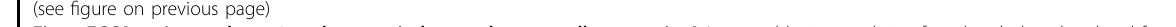
Fig. 5 ECCA activates the p53 pathway to induce melanoma cell apoptosis. A Immunoblotting analysis of total and phosphorylated forms of p53 and p21 in UACC62 cells treated with or without ECCA at the indicated concentrations and times. Red and blue arrows, respectively, indicate the upregulated expression of p-p53 at Ser15 and p21. GAPDH is a housekeeping gene used as a loading control. B Quanti fi cation of the relative levels of p-p53 and p21 in A , as a relative fold change to the respective control cells, indicated by a dashed line as 1, after each phosphorylated protein was normalized to the corresponding total protein band. C Immunoblotting analysis of total and phosphorylated forms of p53 in UACC62, A375, Mel- Juso, M14, and WM115 cells treated with ECCA at 5 μ M at 24 h. Green arrows indicate the upregulated expression of p-p53 at Ser15. GAPDH is a housekeeping gene used as a loading control. D Quanti fi cation of the relative levels of p-p53 in C , as a relative fold change to the respective control cells, indicated by a dashed line as 1, after each phosphorylated protein was normalized to the corresponding total protein band. E UACC62 cells were transfected with three independent p53 siRNAs, and at 48 h after transfection, the cells were treated with 5 µM ECCA. At 24 h, cells were collected for cell viability analysis using the CCK8 assay. F Wild-type (control) and p53-ko UACC62 cells were treated with ECCA (5 µM) or with DMSO as the control, and at 24 h, cells were collected for analysis using the CCK8 assay. G Wild-type (control) and p53-ko UACC62 cells were treated with ECCA (5 µM) or with DMSO as a control, and at 12 h after treatment, cells were analyzed by FACS for cell apoptosis. H Quanti fi cation of apoptotic cells percentage in G. I Wild-type and p53-ko UACC62 cells were treated with 5 µM ECCA for 24 h, then were fi xed and analyzed using an SA- β -gal staining kit to detect senescent cells (blue, white arrows). Scale bars = 100 µm. J Quanti fi cation of SA- β -gal – positive cells (blue, white arrows) based on counting a total of 500 cells in I . K Immunoblotting analysis of total forms of p21 and p16 in wild-type and p53-ko UACC62 cells treated with or without ECCA. GAPDH is a housekeeping gene used as a loading control. Black and gray arrows, respectively, indicate the upregulated expression of p21 and p16. L Quanti fi cation of the relative levels of p21 and p16 in K , as relative fold change to the respective control cells, after each protein was normalized to the GAPDH band. All experiments were carried out three times, and error bars represent means ± SD; P values are indicated with “ * ” , * indicates P < 0.05, ** indicates P < 0.01, *** indicates P < 0.005 when comparing the ECCA-treated group with the control group in ( B and D , comparing the p53-siRNA group with the siRNA-control group in E , and comparing the corresponding two groups indicated by lines in F , H , and J by Student ’ s t